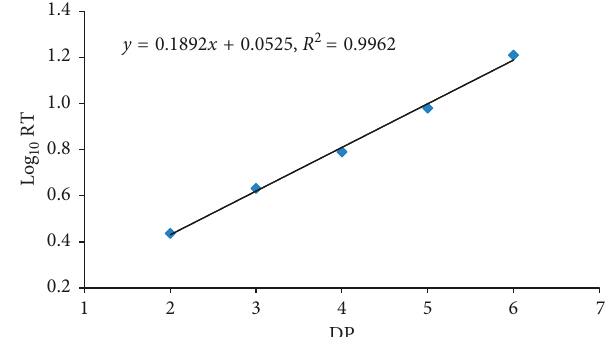
Figure 3: Linear relationship between log 10 RT and DP for COS separated by HPAEC on a CarboPacPA-100 column using isocratic elution with eluent A (water), B (0.2M sodium hydroxide), and C (0.5M sodium acetate) mixture (50 :30: 20, v/v/v) at 0.8 mL/min.